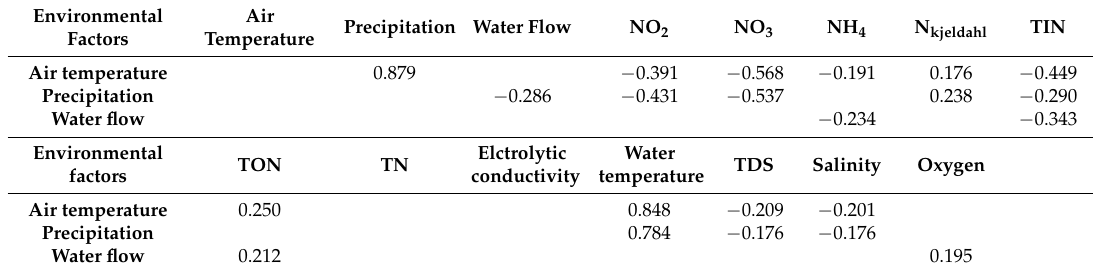
Table 3. Results of the Spearman’s rank correlation. Results are statistically significant at p < 0.05. Environmental Factors